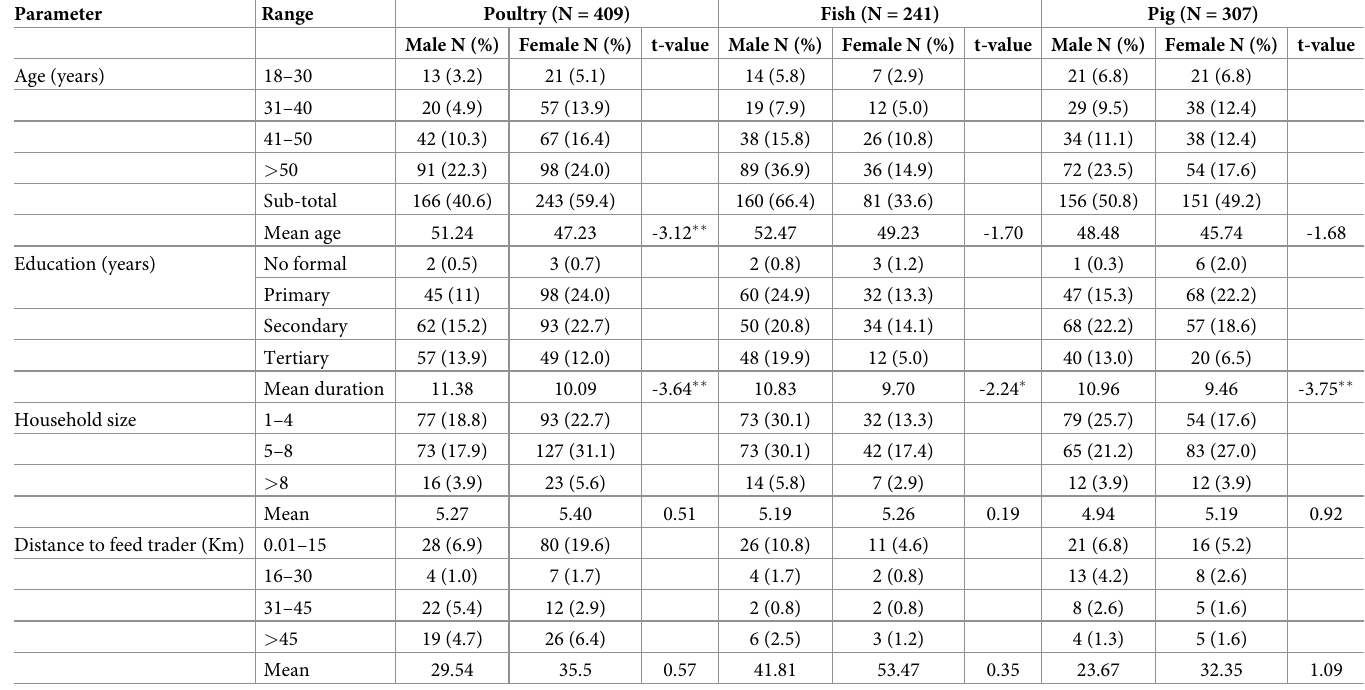
Table 2. Demographic characteristics of the farmer